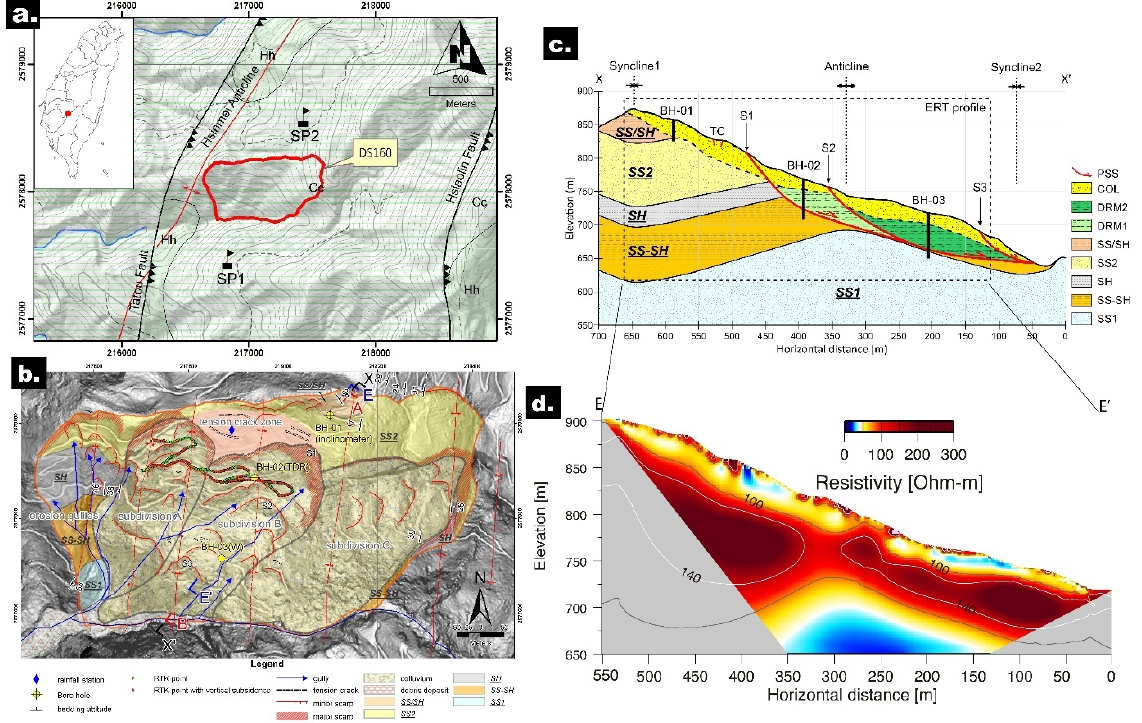
Figure 1. Geological map view and profile of Chashan landslide and the resistivity profile: ( a ) Regional geological map and location of short-period (SP1 and SP2) seismometers. The red line indicates the study area. The Changchikeng Formation (Cc) and Hunghuatzu Formation (Hh) are Miocene sedimentary strata [32]; ( b ) Geological map of the Chashan landslide. L-shaped brackets indicate the start and end points of the profiles: the geological profile (XX ′ ), and the profiles of ERT (EE ′ ) and numerical simulation (AB, see Figure S3). Dots represent the points of the RTK survey. Measured points with vertical subsidence are identified by red dots. The borehole instruments, including the TDR, inclinometer, and groundwater gauge (W), were installed in the landslide region. The diamond represents a rain gauge station. Three subdivisions, A, B, and C, are separated by topographic features such as scarps (S1, S2, and S3) and gullies. A tension crack zone was found by conducting field surveys above S1. Most attitudes of bedding planes are exposed and measured near erosion gullies and boundaries of the Chashan landslide; ( c ) Geological profile. Three boreholes, BH-01, BH-02, and BH-03, are at the top, middle, and toe of the slope, respectively. TC: tension cracks; PSS: potential slip surface; COL: colluvium; DRM: displaced rock mass. Two DRMs are separated by PSS; ( d ) Resistivity tomography. The isoresistivities of 100 and 140 are denoted by the gray and white lines, respectively. The gray-shaded area indicates the poor resolution in the inversion.